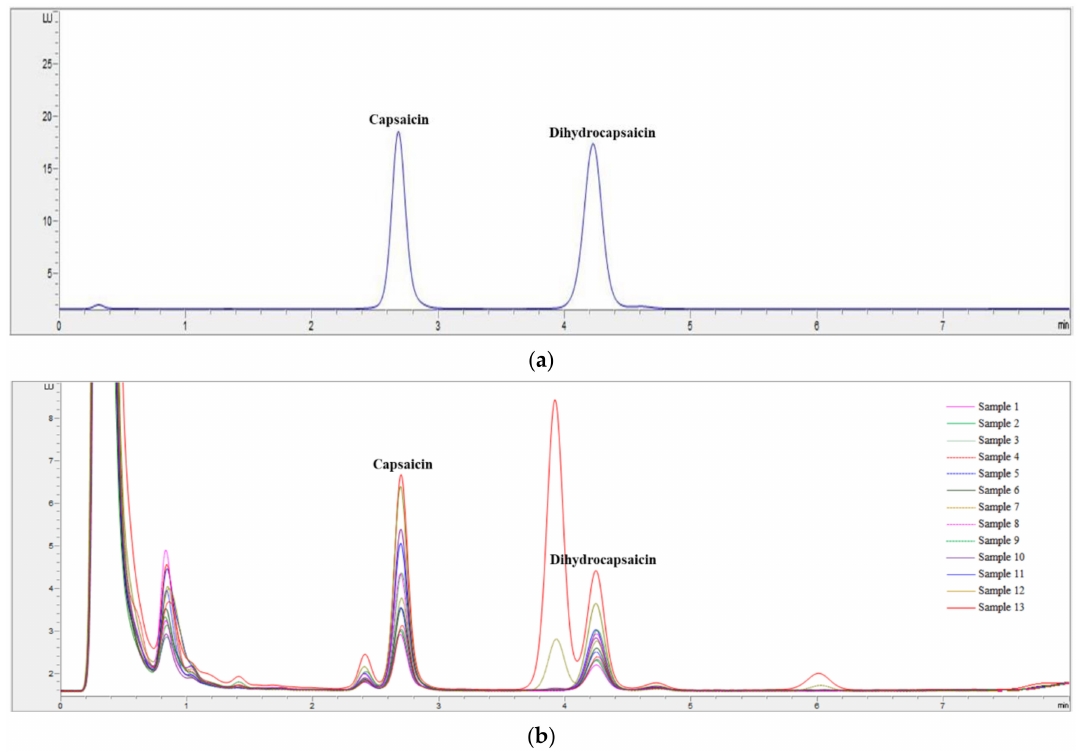
Figure 1. High-performance liquid chromatography (HPLC) chromatograms of: ( a ) a standard solution containing capsaicin and dihydrocapsaicin; and ( b ) capsaicin and dihydrocapsaicin in 13 commercial kimchi samples.